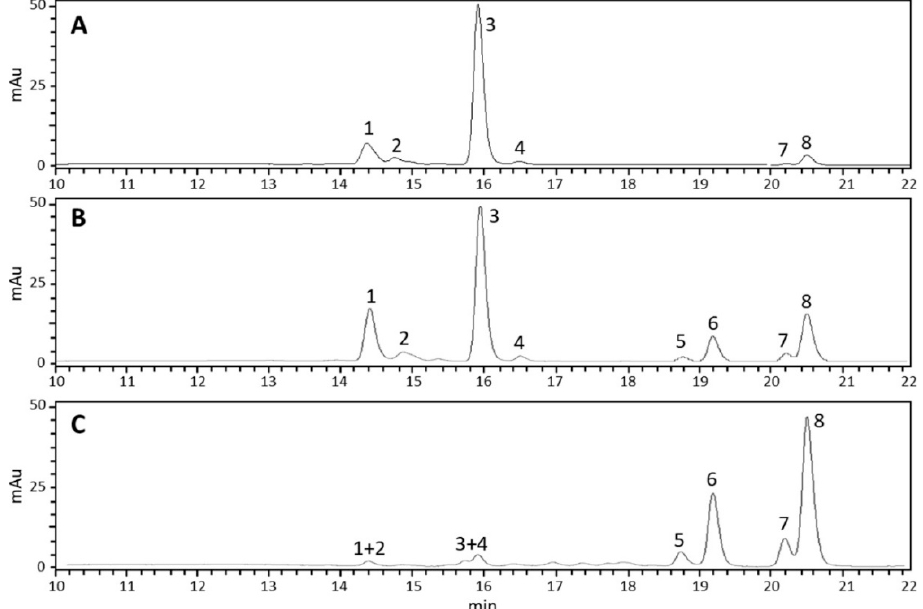
Figure 8. HPLC chromatograms (DAD λ 655 nm) showing Chl and Chl degradation products in healthy Lima bean leaves ( A ), TSSM-infested Lima bean leaves ( B ), and TSSMs ( C ). Numbers refer to: Chl b (1); Chl b’ (2); Chl a (3); Chl a’ (4); Pheo b’ (5); Pheo b (6); Pheo a’ (7); Pheo a (8). UV/Vis spectra of the eight compounds are shown in Supplementary Figure S1. Table 1. Chemical composition of chlorophylls and chlorophyll degradation products in healthy and TSSM-infested Lima bean leaves and in TSSMs. Values are reported as mean (± standard deviation) values of at least three biological replicates. For each raw, different letters indicate significant differences ( P ≤ 0.05). For further statistical information, see Supplementary Table S1.